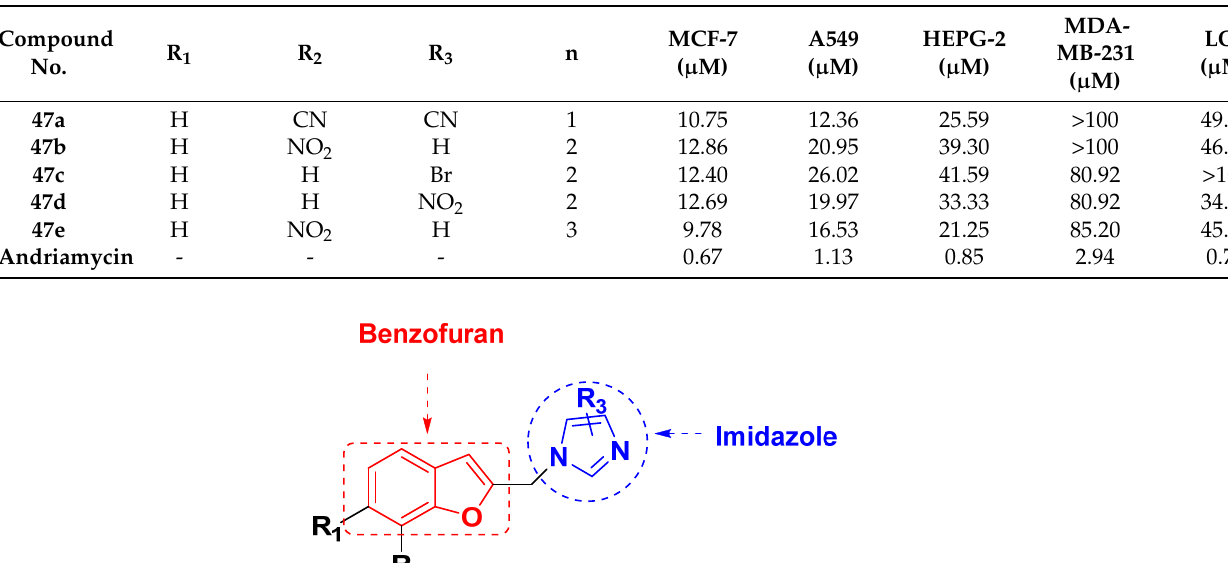
Table 40. In vitro cytotoxic activities of imidazole-based artemisinin hybrid compounds 47 ( a – e ).